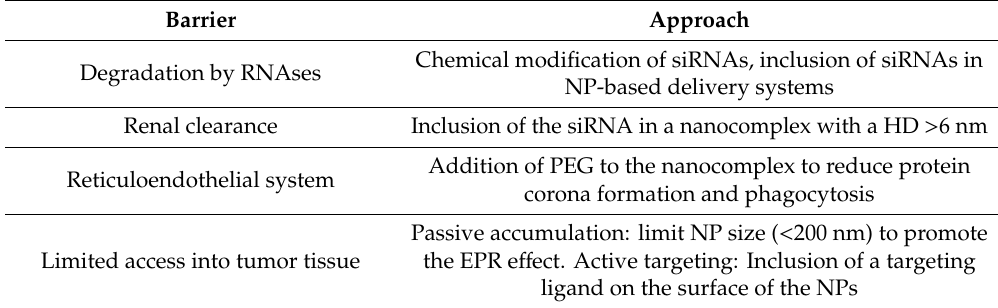
Table 1. Physiological barriers in siRNA delivery by intravenous